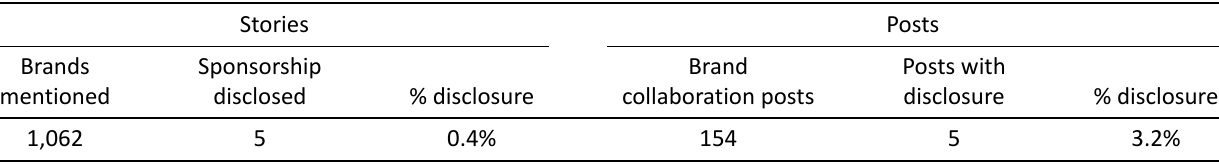
Table 4. Disclosure in